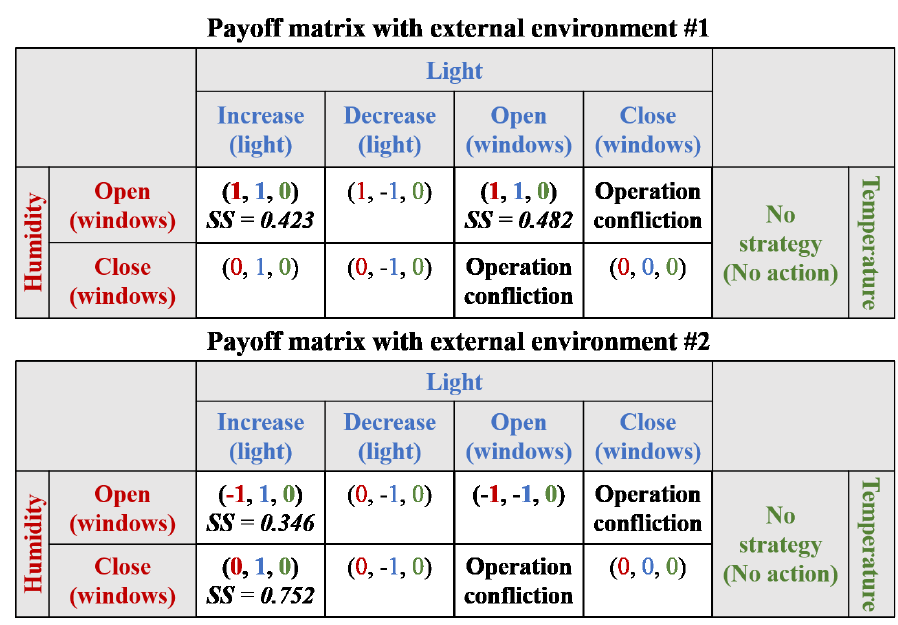
Figure 9. Payoff matrix for Scenario #2 ( α = 0.5 and β = 0.5).